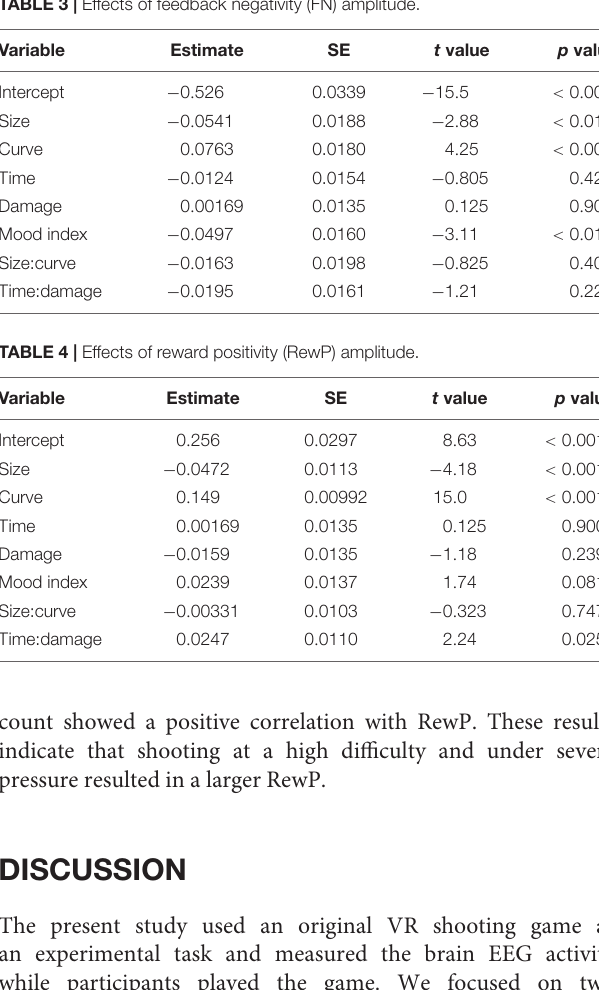
TABLE 3 | Effects of feedback negativity (FN) amplitude.